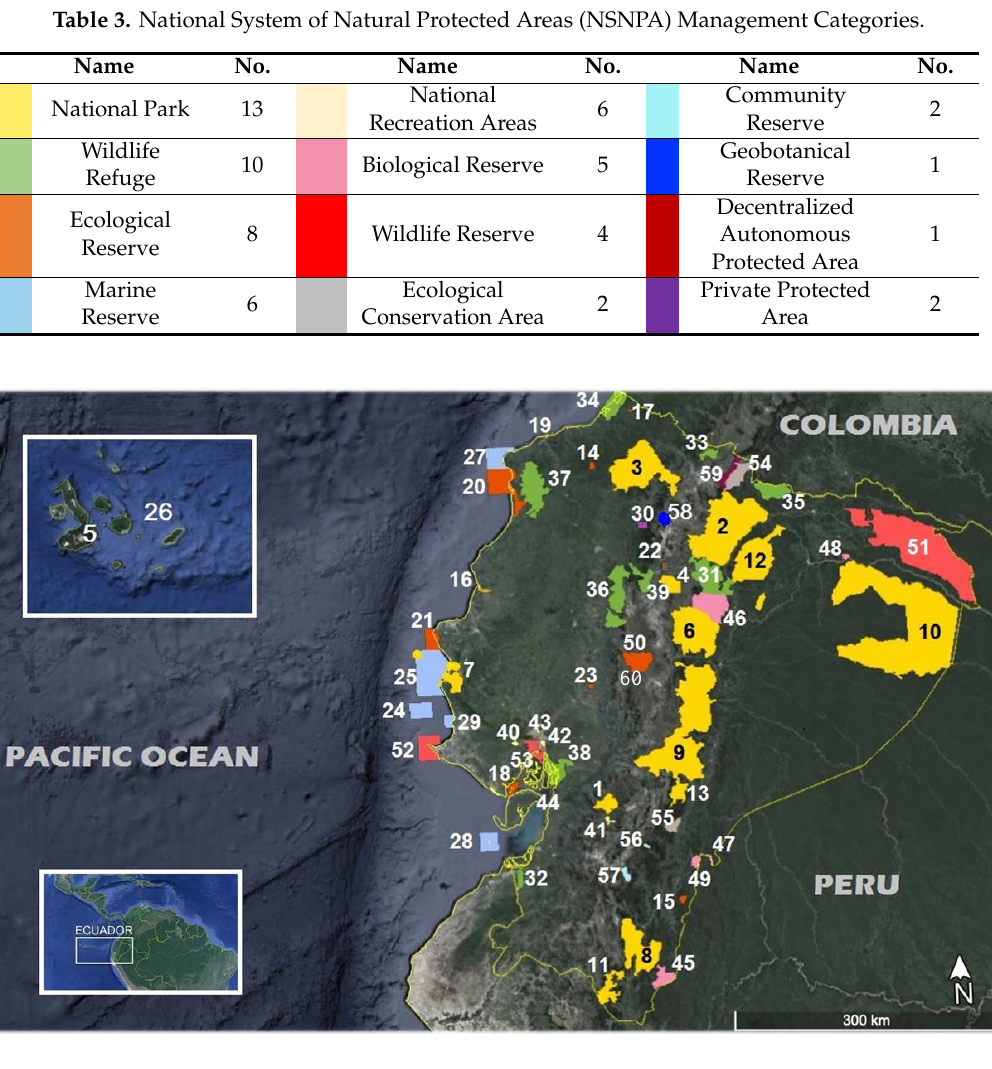
Figure 1. Distribution of Protected Areas under National System of Natural Protected Areas (NSNPA) in Ecuador by Management Category